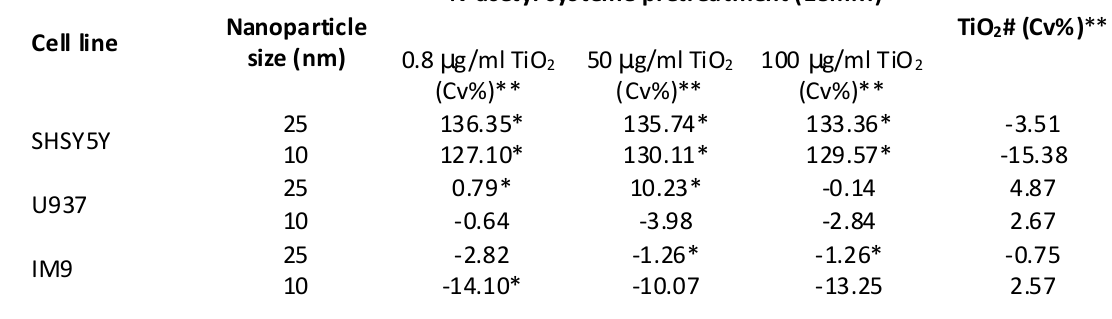
Table 3.: The effect of two different sizes of TiO vs. TiO -treated only 2 ** Increase in cell viability (per cent) at the end of the 24-hour incubation period. #The mean value of cell viabilities (per cent) for ten different concentrations (from 0.2 m g/ml to 100 m g/ml) of TiO NPs at the end of the 24-hour incubation period. 2 *p < 0.05; NAC treated group compared to mean value of cell